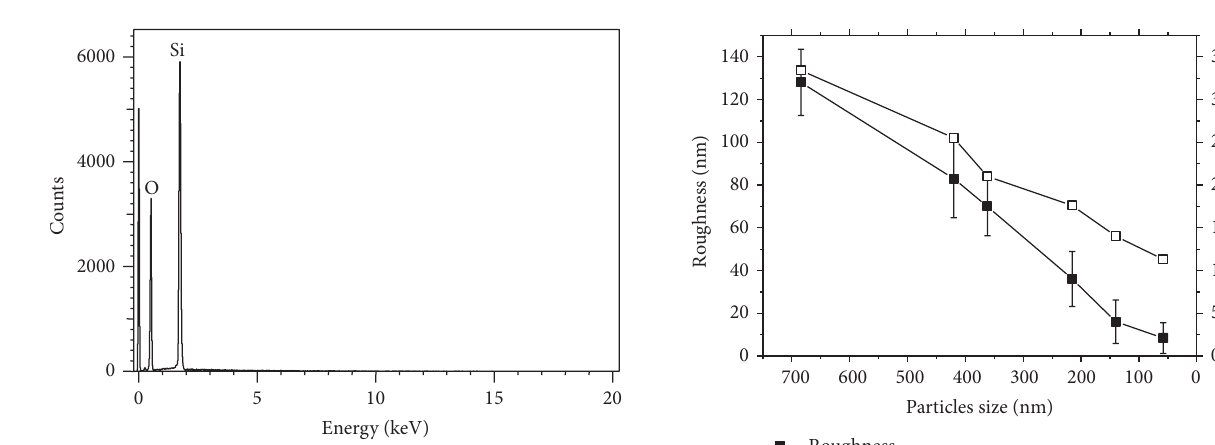
Figure 4: EDS spectrum of the SiO 2 nanoparticles.